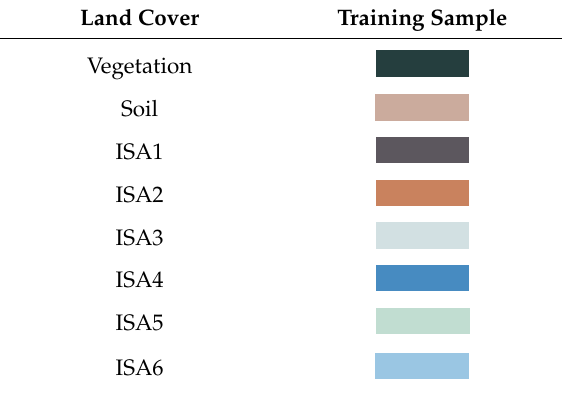
Table 1. Training samples of each land-cover type.